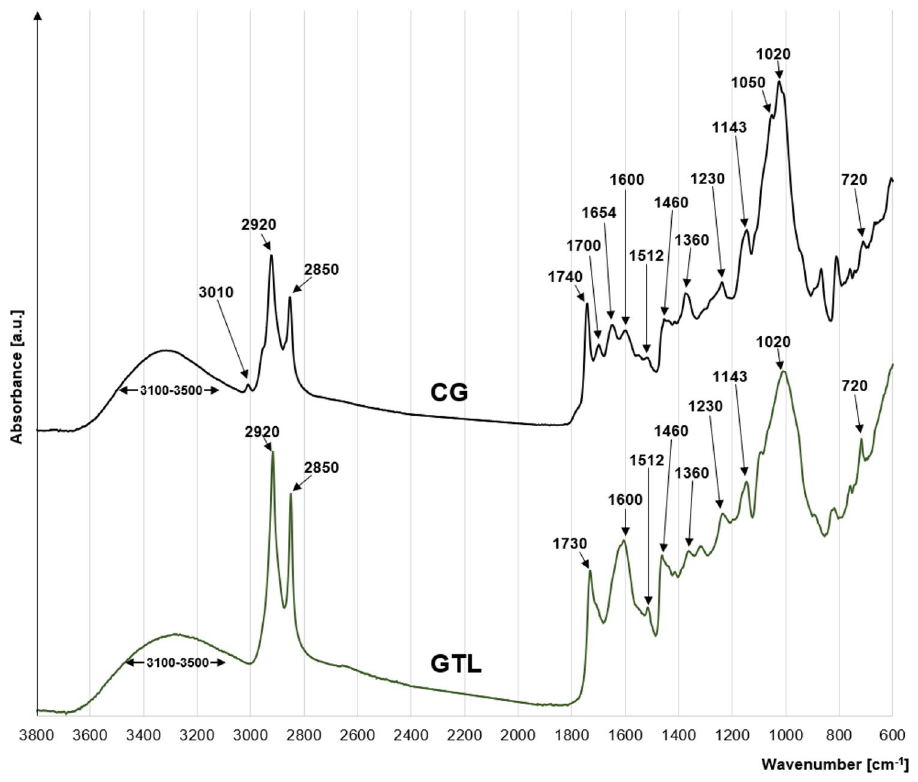
Figure 1. FTIR spectra of CG and